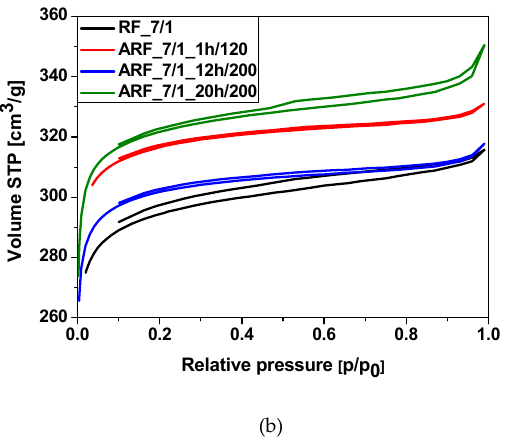
Figure 4. Nitrogen adsorption–desorption isotherms for the samples obtained without ( a ) and with ( b ) addition of potassium oxalate.